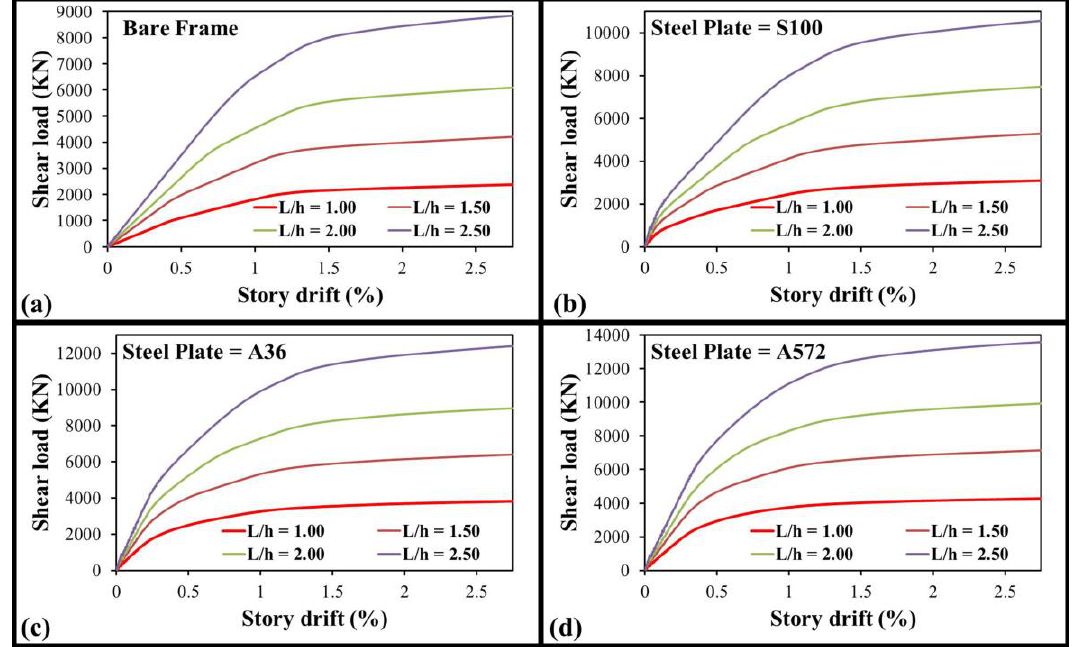
Fig. 5 . Pushover analyses results: (a) bare moment frame (b) SPSW with low-yield steel plate (c) SPSW with medium-yield steel plate (d) SPSW with high-strength steel